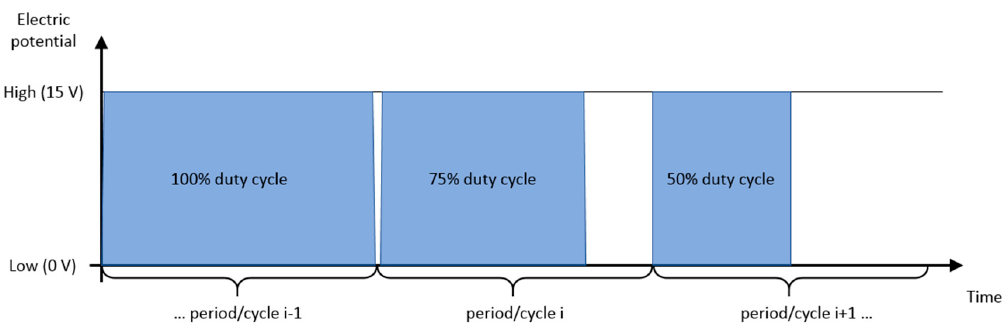
Figure 4. PWM duty cycle definition. The developed EP µ AM control system allows individual control of each microelectrode site in the electrode array.